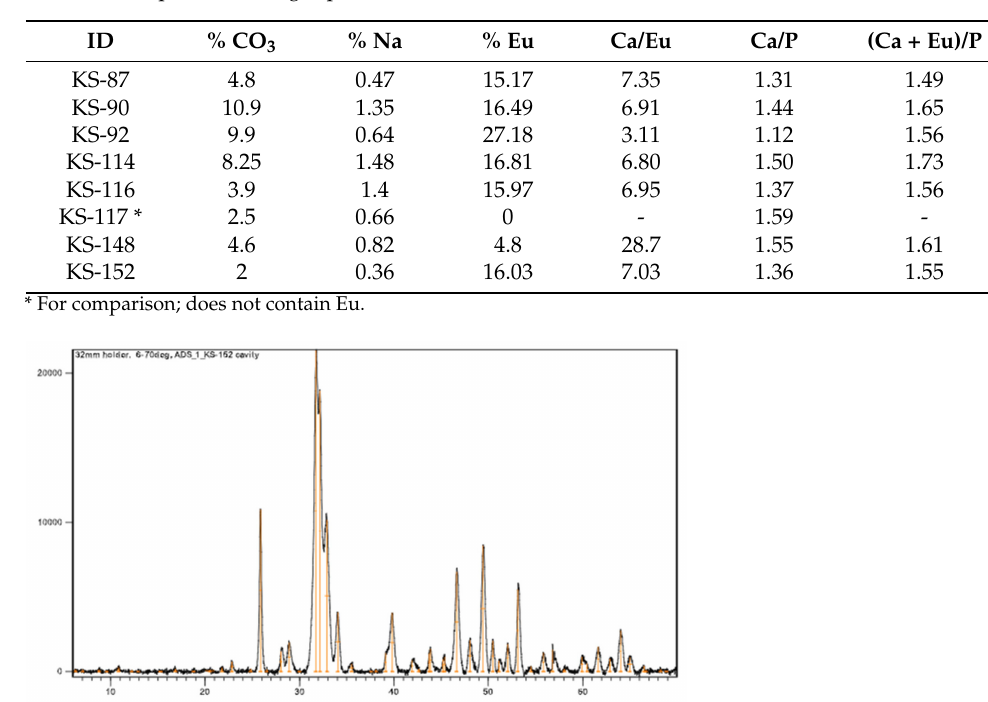
Table 2. Composition (weight percent) and element ratios.